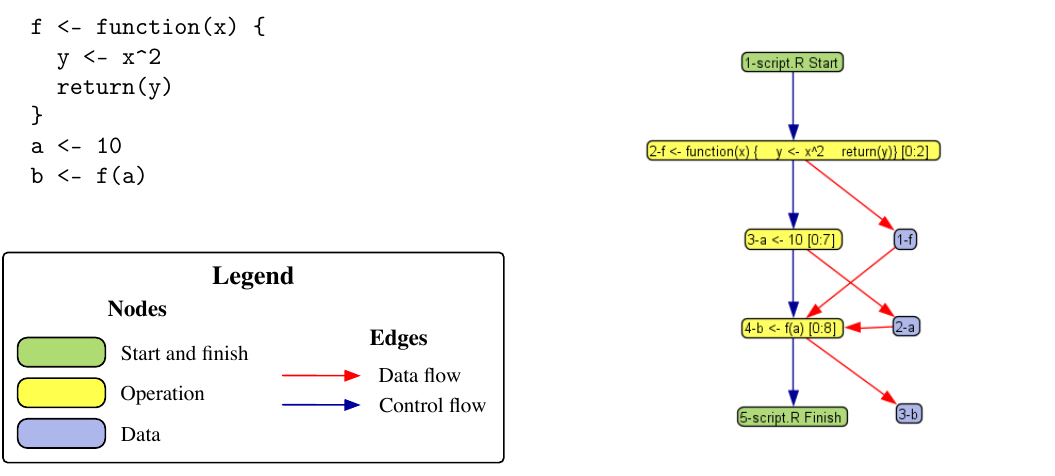
Figure 1. DDG without function